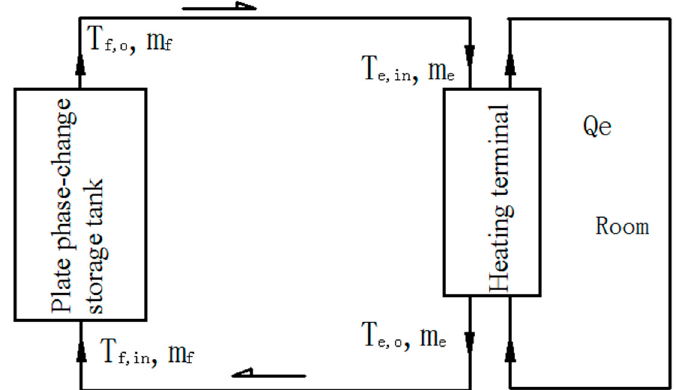
Figure 11. Operation model of the supply of heat from the phase-change thermal storage tank to the room.